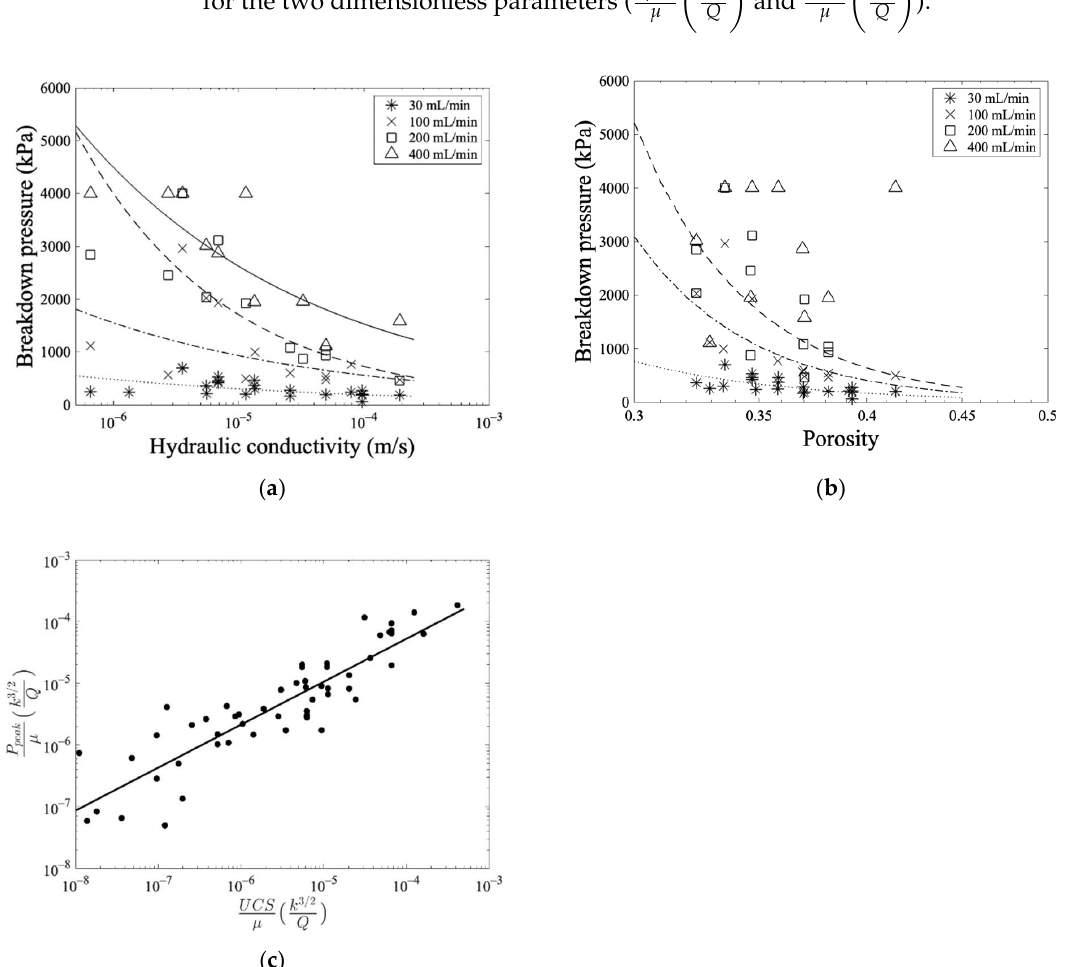
Figure 12. Correlations of breakdown pressures obtained during glycerine injection experiments in bio-cemented sands at various flow rates with respect to ( a ) hydraulic conductivity (m/s) and ( b ) porosity; ( c ) dimensionless peak pressure vs. dimensionless stress (strength) for all injection tests. The results suggest that peak pressure is clearly dependent on the permeability and porosity of the granular medium, which interacts with the flow rate, and the transition between infiltration and damage of the formation via cracking depends on the previous factors but also on the strength of the specimen. The following two equations have been traditionally used for fluid flows in porous media: the hydraulic fracturing tensile